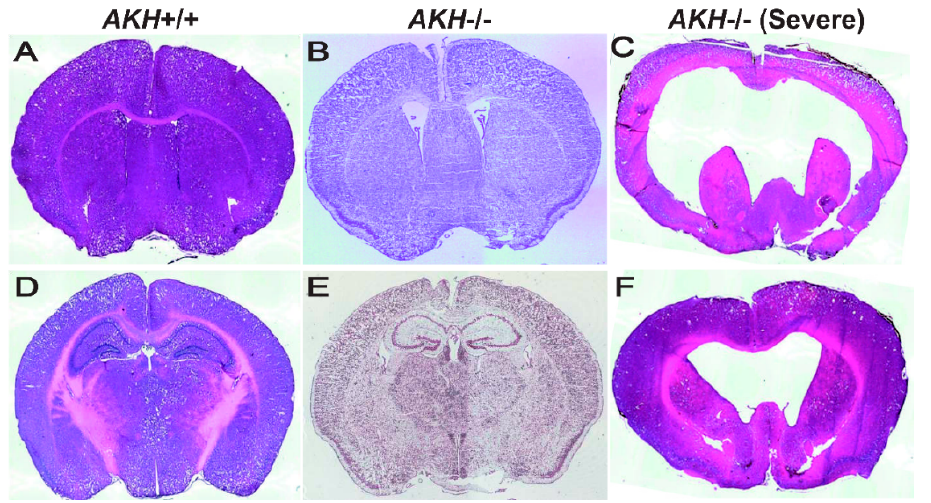
Figure 2. Histomorphology of the SVZ ( A – C ) and the hippocampal regions ( D – F ) in mouse brain on hematoxylin-eosin (HE) ( A , C , D , F ) and Nissl ( B , E ) staining. AKH +/+ ( A , D ), AKH - / - ( B , E ), and AKH - / - hydrocephalus-like mouse ( C , F ).